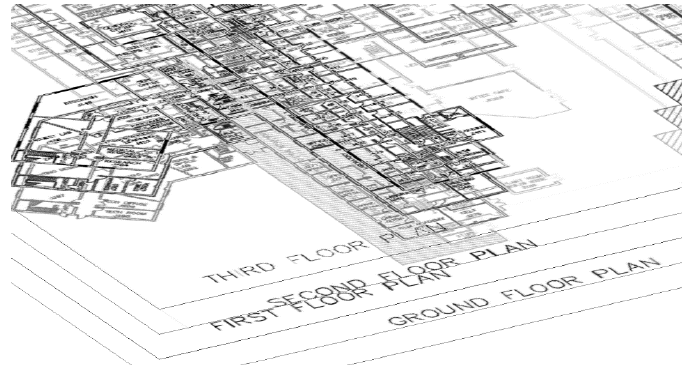
Figure 19. Building plans organized as raster background layer for all